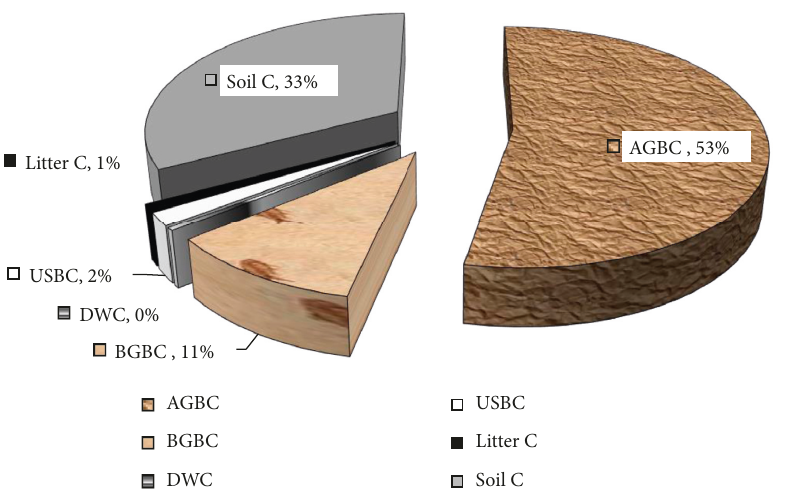
Figure 7: Carbon stock distribution and percent share of each carbon pool in Anshirava